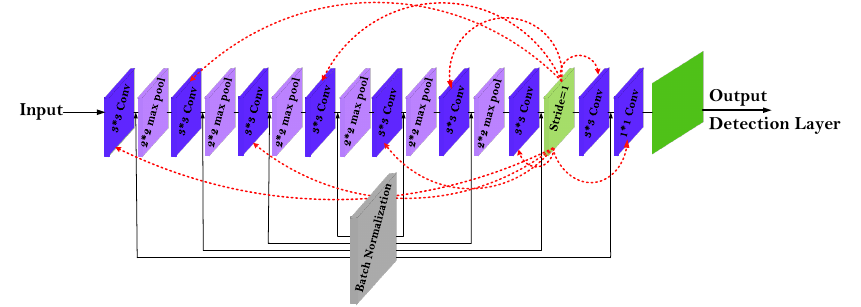
Figure 3. The structure of